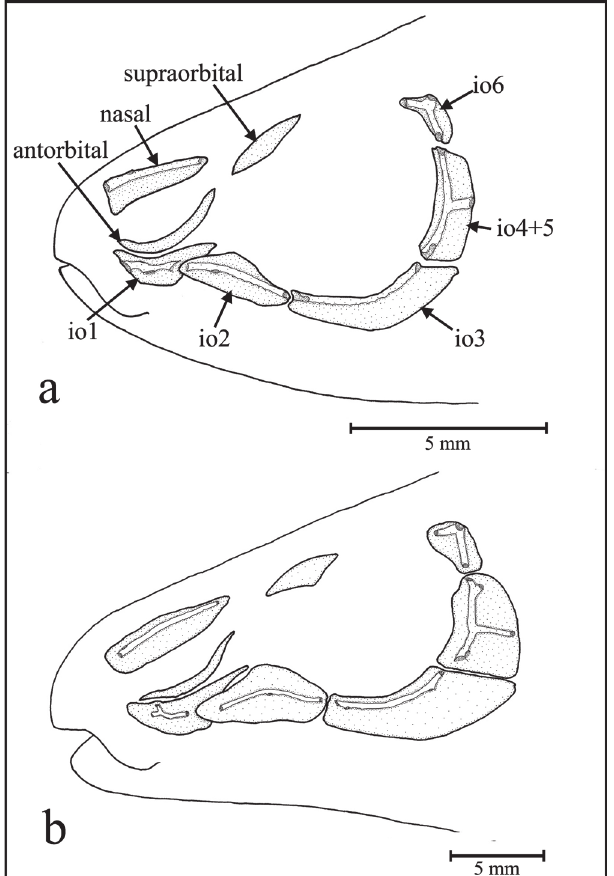
Fig. 9. Lateral view of head of Leporinus reticulatus , a - paratype, MZUSP 44782, 52.4 mm SL, b - MZUSP 99734, 111.0 m SL. io =